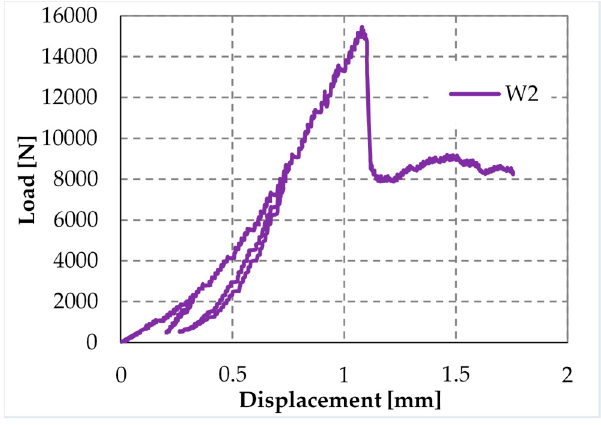
Figure 43. Load/displacement diagram of Specimen W2.